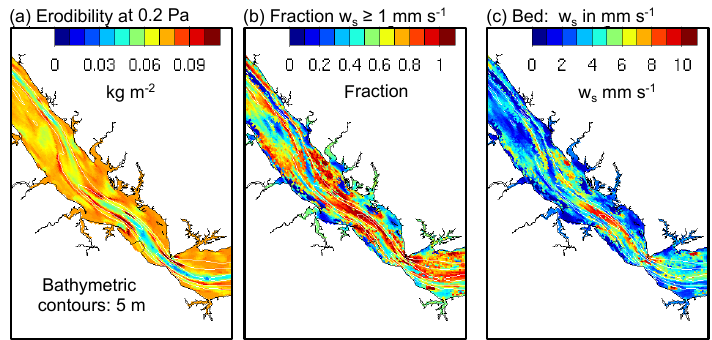
Figure 10. Model estimates of seabed properties after 2 months of tidal forcing and constant average freshwater discharge. (a) Erodibility of the seabed, calculated as the thickness of the layer having a critical shear stress exceeded by 0.2Pa. (b) Fraction of the surficial sediment in the faster-settling size class. (c) Average settling velocity of surficial